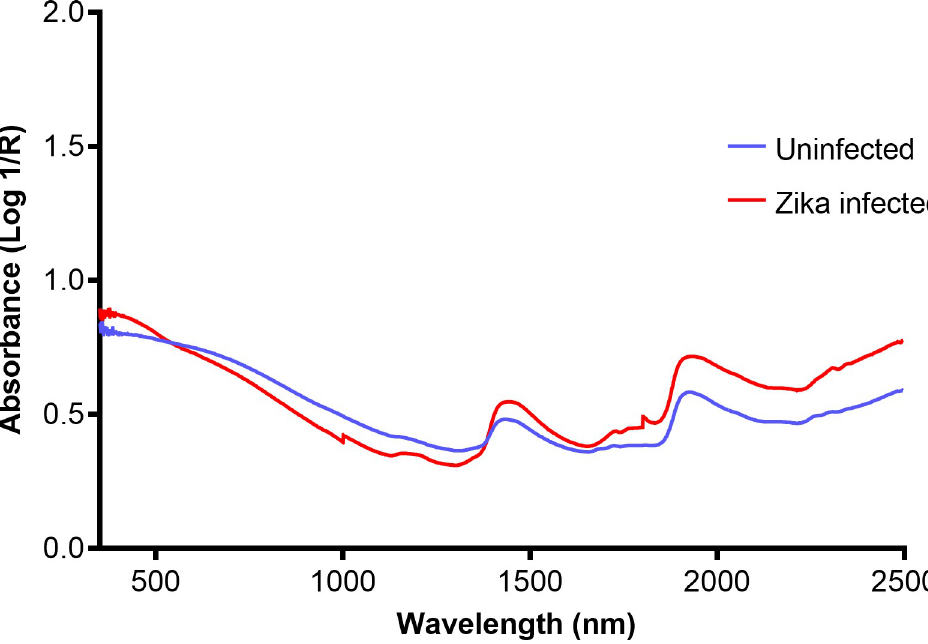
Fig 1. An example of an averaged NIRS raw spectra collected from the heads and thoraces of ZIKV-infected (red) and uninfected (blue) Ae . aegypti mosquitoes. Adapted from Fernandes and colleagues [90].